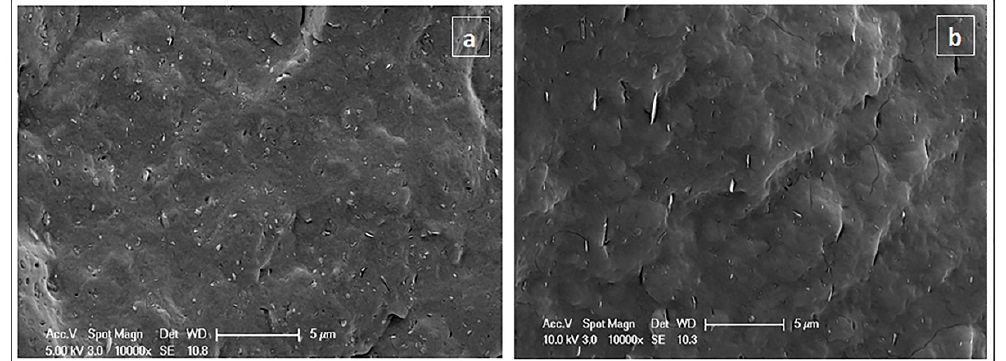
Figure 2. SEM images of composites ( a ) PHBV/1OSBN ( b ) PHBV/1OSFBN.